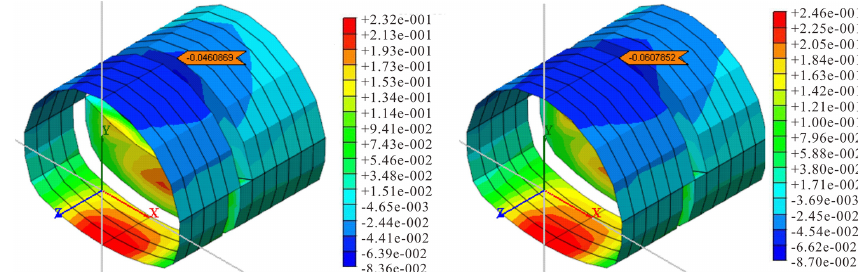
Figure 14. Vertical displacement nephogram of the vault with the upper bench excavation (mm).